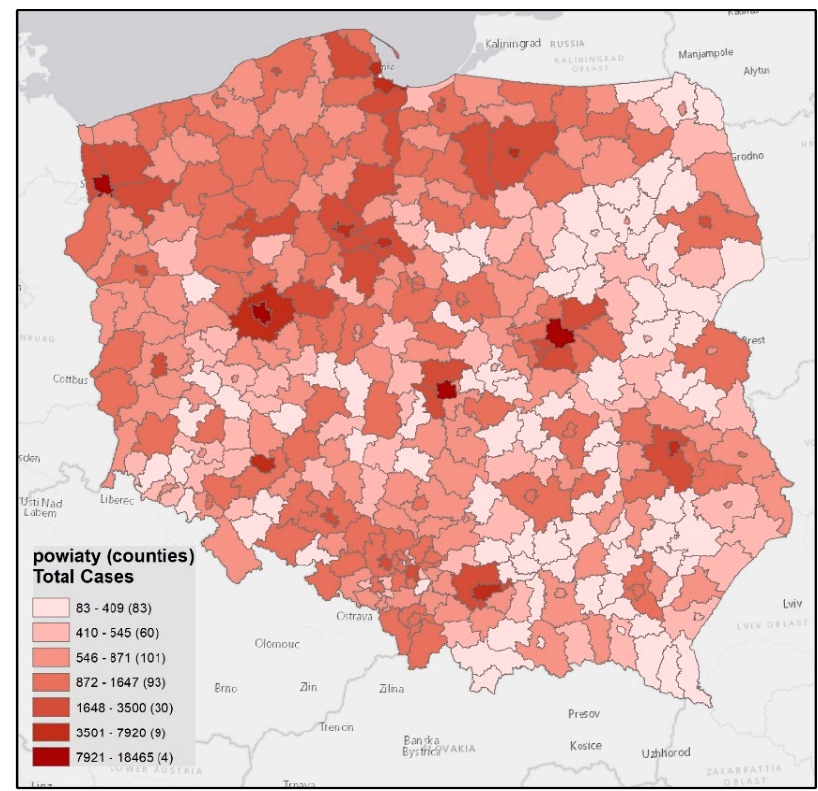
Figure 3. Total number of infections by county in Poland (from weeks 48 to 52 of 2020); our study was based on data from the Ministry of Health,